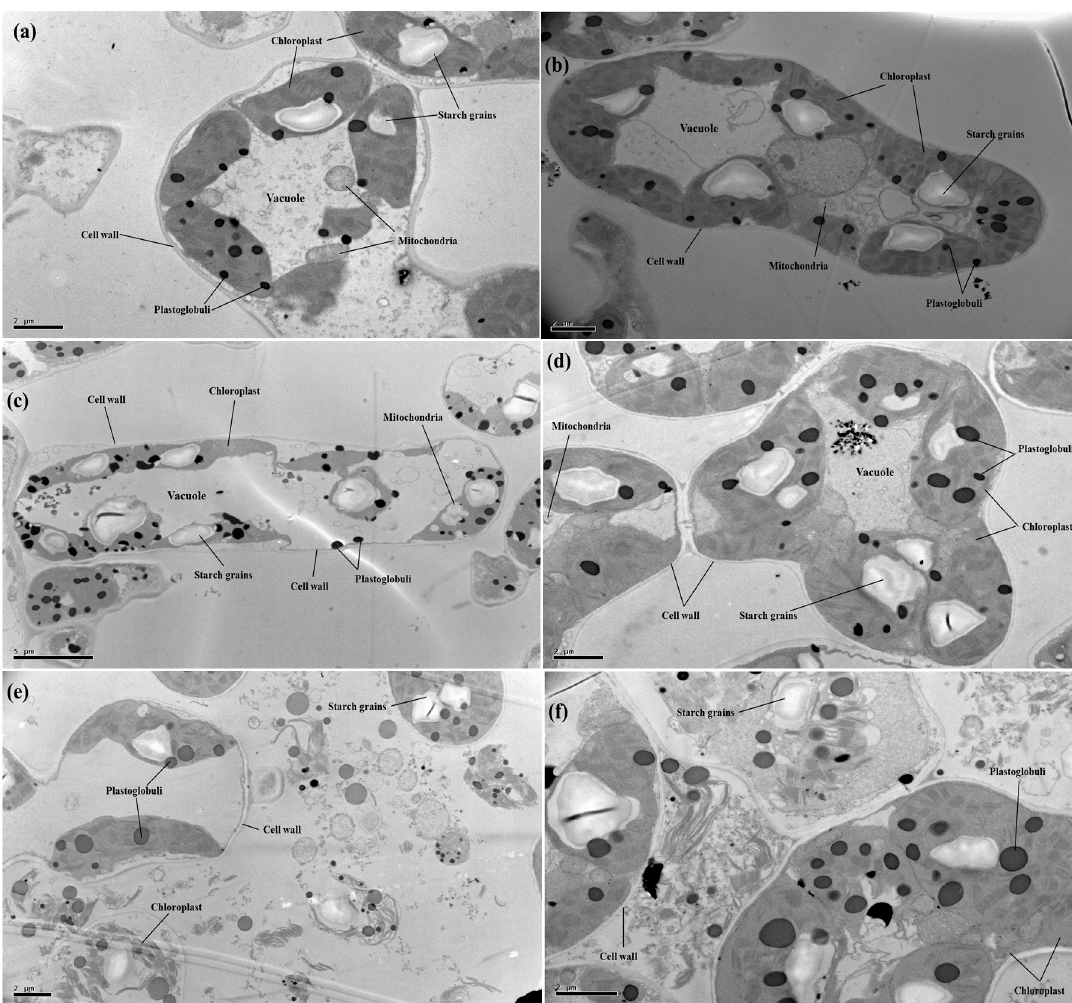
Figure 4. Transmission electron microscopy (TEM) images of C. capsularis leaf cells. The abbreviations are as follows: ( a ) Cu 0 CA 0 (10,000), ( b ) Cu 0 CA 1 (10,000), ( c ) Cu 1 CA 0 (5000), ( d ) Cu 1 CA 1 (10,000), ( e ) Cu 2 CA 0 (5000), and ( f ) Cu 2 CA 1 (10,000).